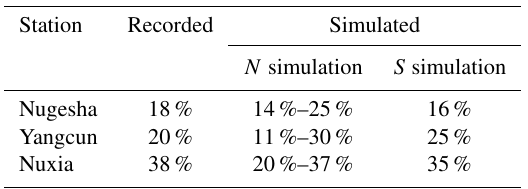
Table 3. Fractions of meltwater-induced streamflow to total runoff during the evaluation period for three